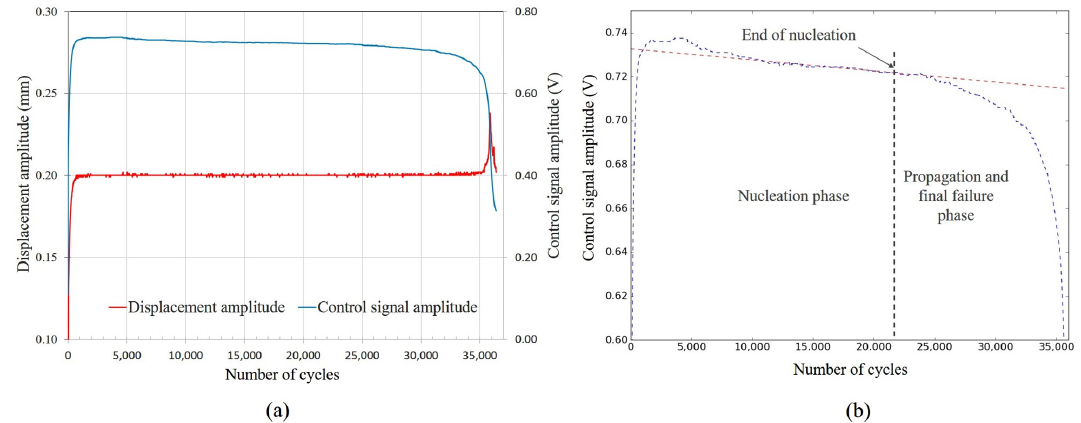
Figure 8. Controller response; ( a ): amplitude of the control signal and displacement for the horizontal specimen built with nominal parameter and ( b ): identification of the nucleation and propagation phase.